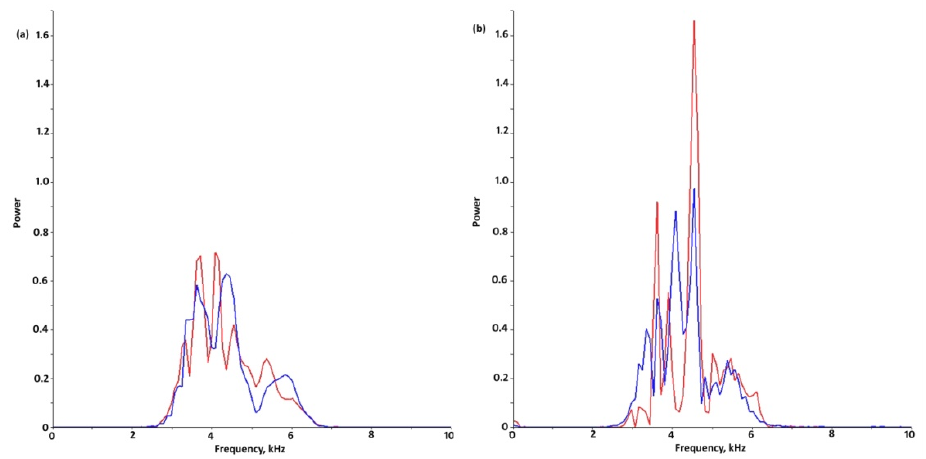
Figure 4. Stacked normalized power spectra [1/kHz]: ( a ) sand (site 1-red line), site 2 (blue line). ( b ) sandstone (site 3—red line), site 4 (blue line).